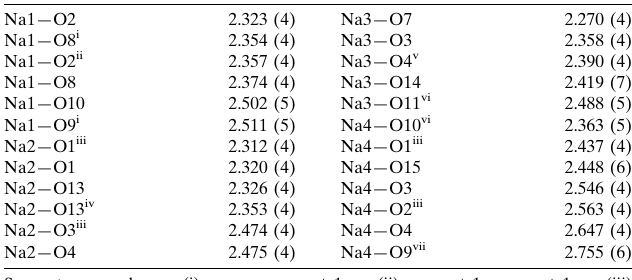
Selected bond lengths (A˚ ).